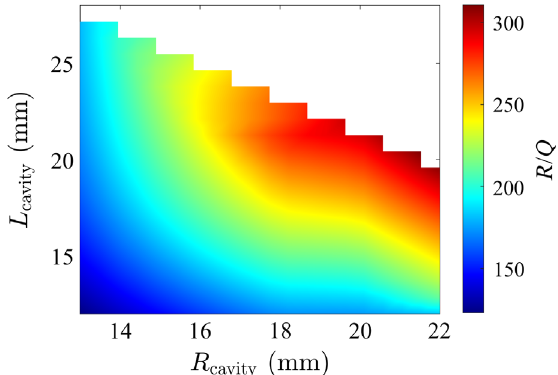
FIG. 3. R=Q variations of the cavity at 4.76 GHz with the cavity length and radius.